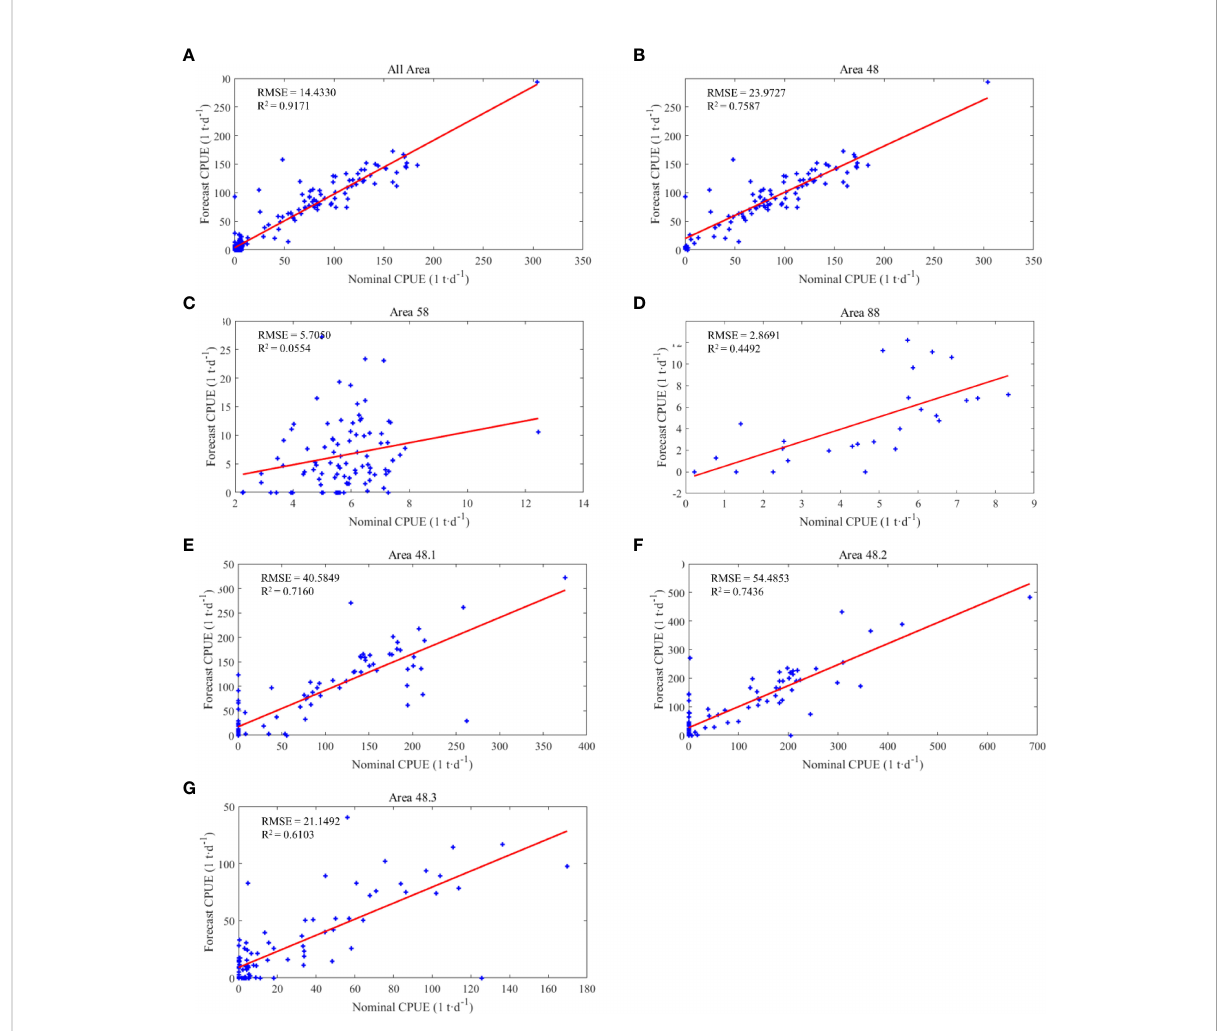
FIGURE 14 Results of nominal CPUE and predicted CPUE correlation analysis. (A) is the result of aggregated data for all fi shing areas, (B – D) are the results for FA 48, 58, and 88, respectively; (E – G) are the results for SFA 48.1, 48.2 and